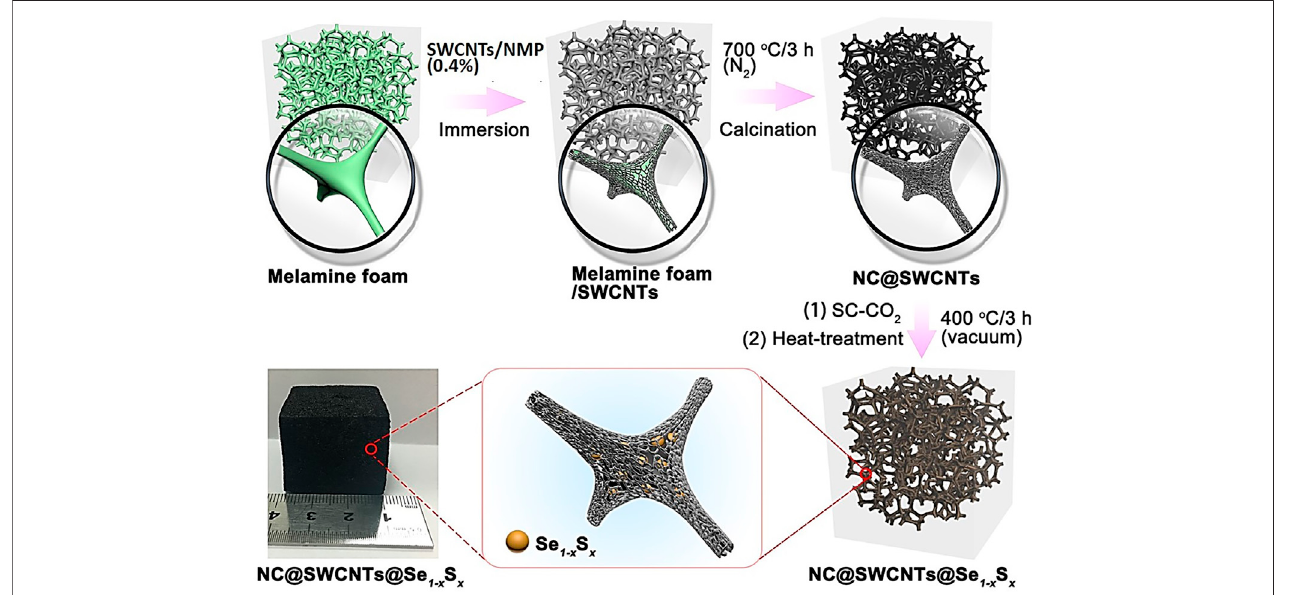
FIGURE 1 | Schematic illustration of the synthetic process of NC@SWCNTs@Se 1- x S x .